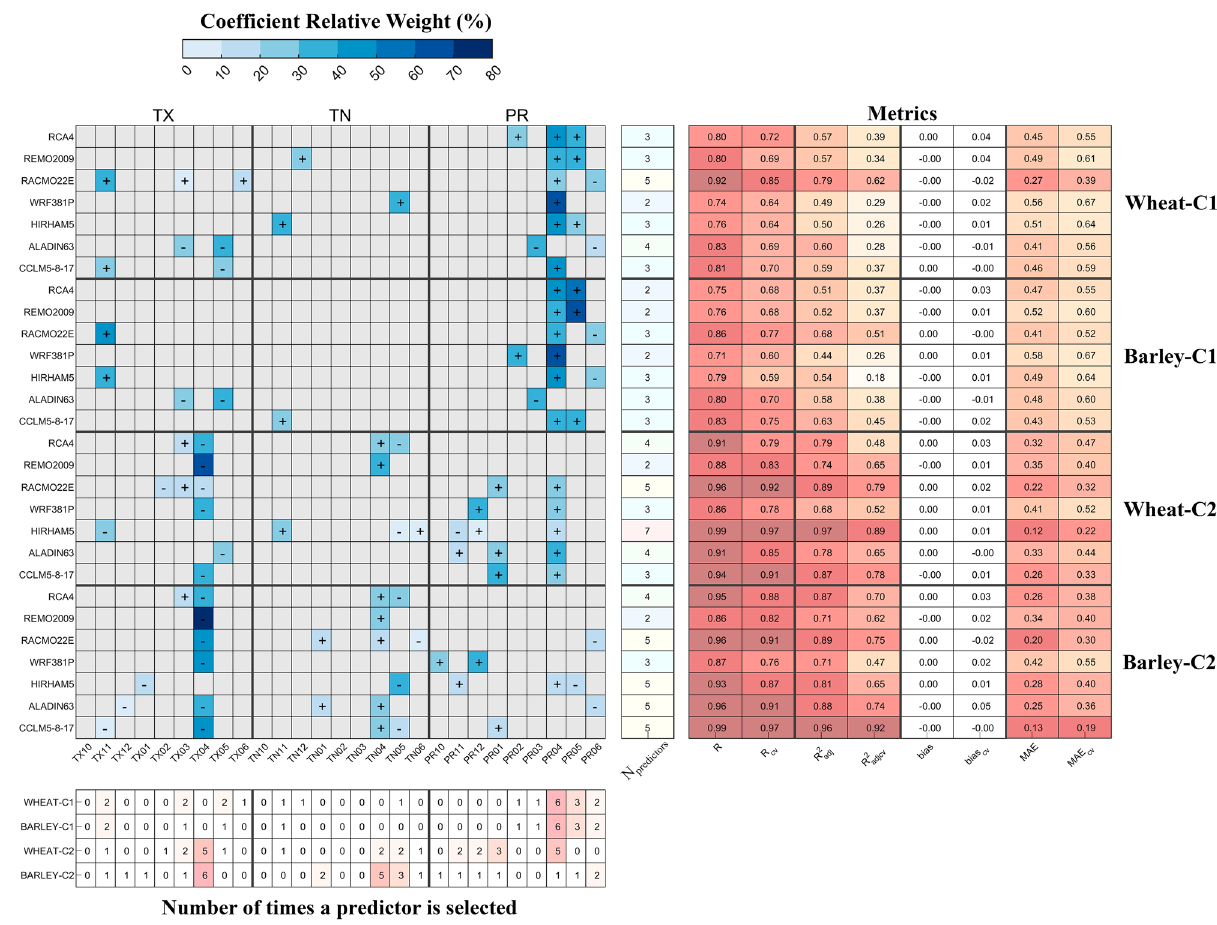
Figure 3. Representation of the selected predictors (displayed in tones of blue) for each CORDEX-Evaluation RCM. The matrix is divided into 9 blocks corresponding to TX, TN, and PR predictors from October to June (left to right), and the 7 RCMs for wheat and barley in cluster 1, and wheat and barley in cluster 2 (top to bottom). Tones of blue indicate the relative percentage of the coefficient associated to a given predictor and sum to 100% for each RCM. Symbols ‘+’ and ‘-’ specify if the coefficient is positive or negative, respectively. The bottom table shows the number of times a predictor is selected by cereal and cluster. The single column table at the right of the matrix indicate the number of predictors by RCM, cereal, and cluster. The table on the right displays the metrics associated to the comparison between cereal yields observed and predicted with regression 2 models before and after cross-validation (cv): correlation R, R ajd , bias, and MAE, in order from left to